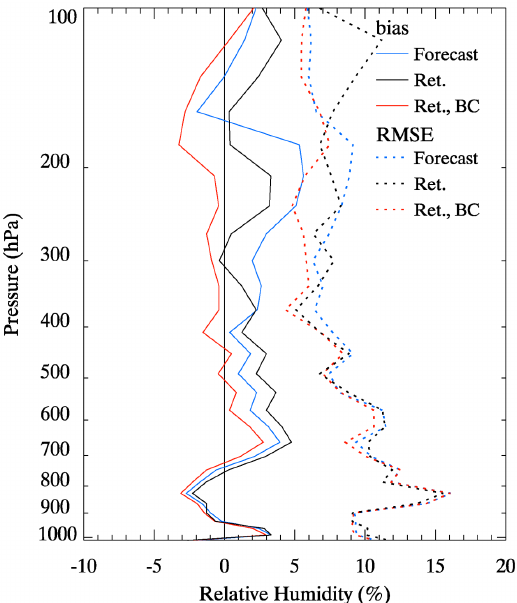
Figure 3. Validation of retrieved moisture profile with radiosonde data (from August 2016) before ( black ) and after ( red ) the bias correction compared to the model forecast ( blue